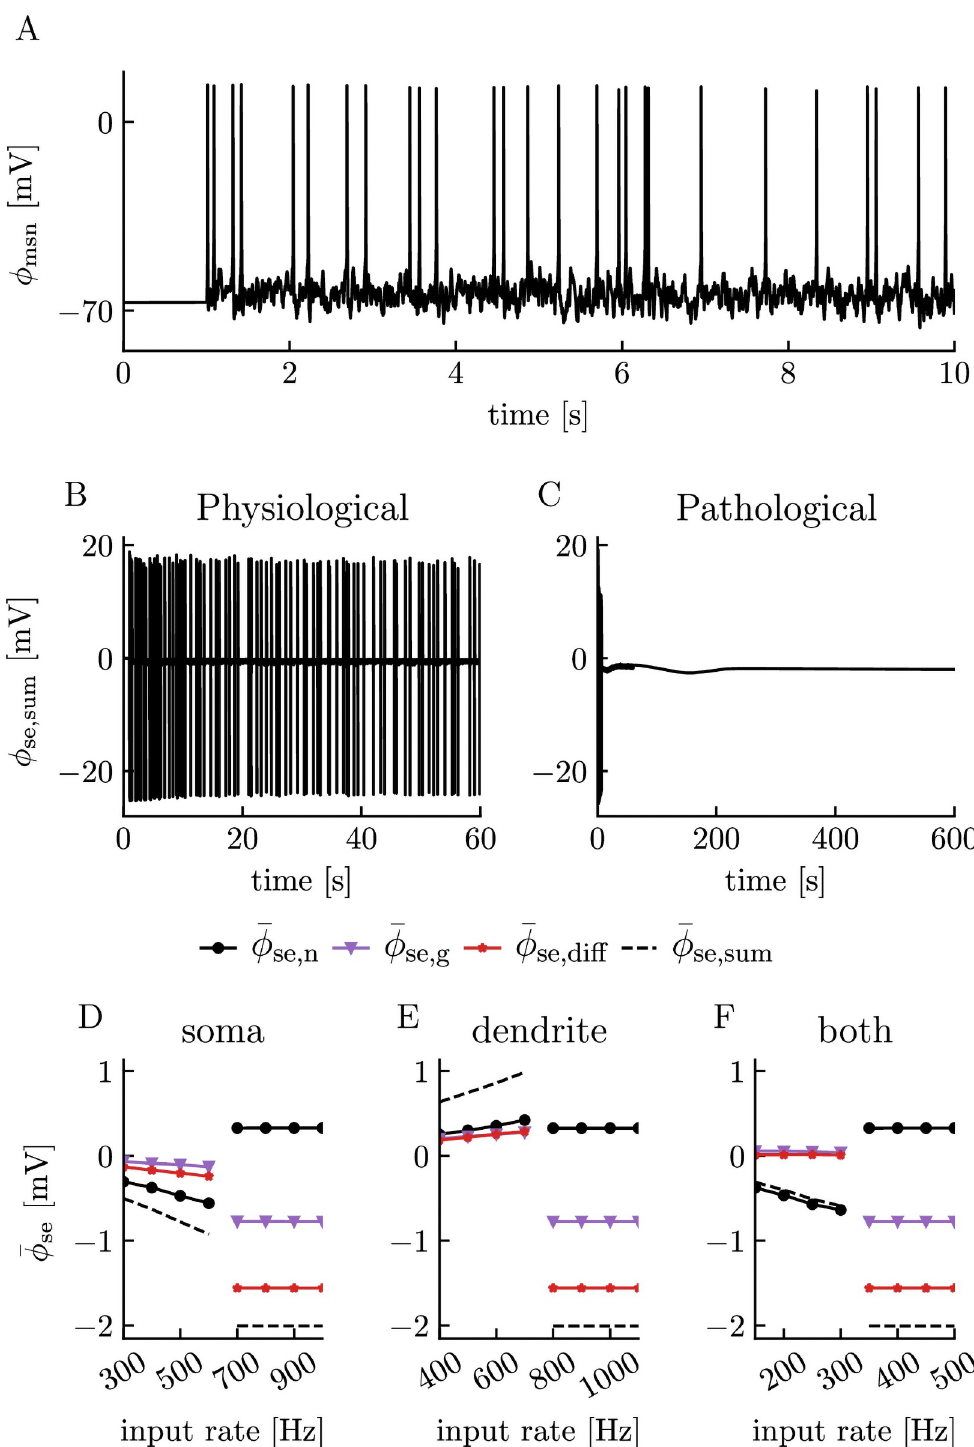
Fig 7. Effects of neurons, glia, and diffusion on slow potentials under AMPA stimulus conditions. ( A ) Somatic membrane potential of the neuron responding to a 300 Hz Poissonian AMPA spike train delivered to the soma between t = 1 s and t = 10 s. ( B ) Extracellular potential (oustide soma) during physiological steady-state firing obtained with a somatic synaptic input rate of 300 Hz between t = 1 s and t = 60 s. The simulation was ended at t = 60 s. ( C ) Extracellular potential (outside soma) during pathological conditions obtained with a synaptic input rate of 700 Hz between t = 1 s and